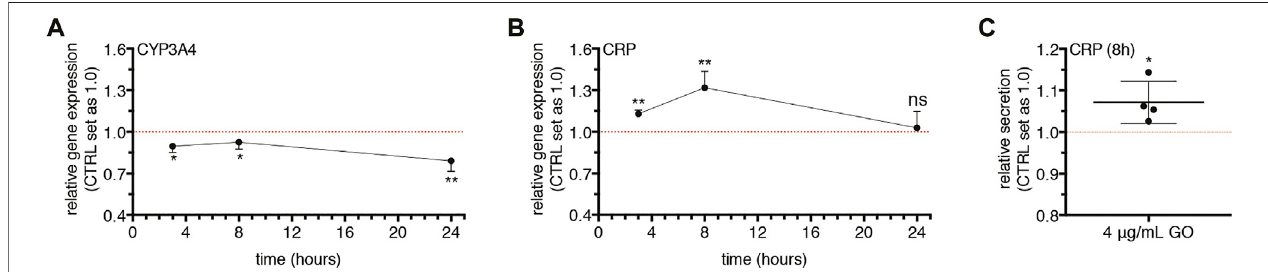
FIGURE7| Effectsof4 μ g/mlGOonCYP3A4andCRPgeneexpressionandCRPsecretionovertime. (A – B) RelativegeneexpressionofCYP3A4 (A) andCRP (B) in GO-treated cells versus untreated cells (indicated as CTRL) at 3, 8, and 24 h of treatment. Results are expressed as means ± SD values of at least three independent experiments.Thesymbols “ * ” , “ ** ” and “ ns ” referto p ≤ 0.0256, p ≤ 0.0086and p > 0.05,respectively,calculatedversusCTRL(unpaired t -Test). (C) Relativesecretionof CRP in GO-treated cells versus untreated cells (indicated as CTRL) after 8 h of treatment (indicated as 8 h). Results are expressed as mean ± SD value of